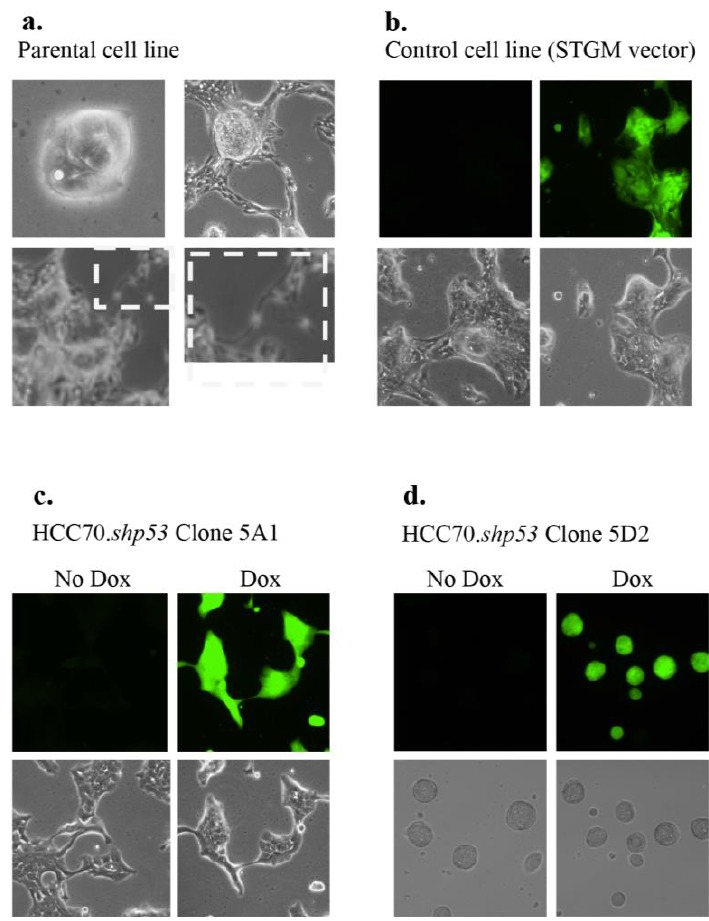
Figure 4. Morphology of HCC70.shp53 5A1 and 5D2 diverge from that of parental cell line. ( a ) Images of light microscopy of live HCC70 parental cell (boxed panel shows increased magnification on the right of the same region boxed on the left) and ( b ) STGM-control cell lines are shown. Fluorescent microscopy showing GFP indicates that Dox was added to the culture conditions. In the STGM-control there was no mtp53 knockdown. During cloning of the HCC70.shp53 pool we isolated clones that were representative of each type of morphology. ( c ) Specifically, HCC70.shp53 5A1 exhibited branched colony structures only (bottom left) and ( d ) HCC70.shp53 5D2—stem cell-like round colony